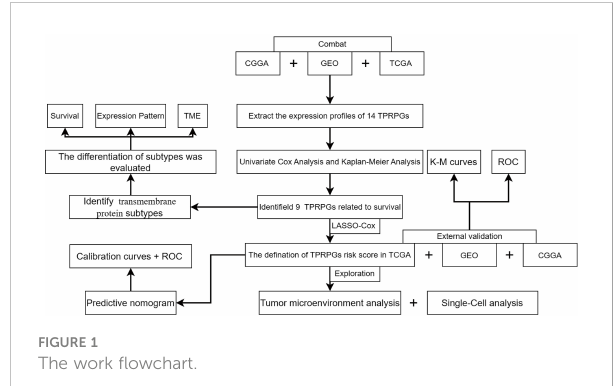
FIGURE 1 The work fl